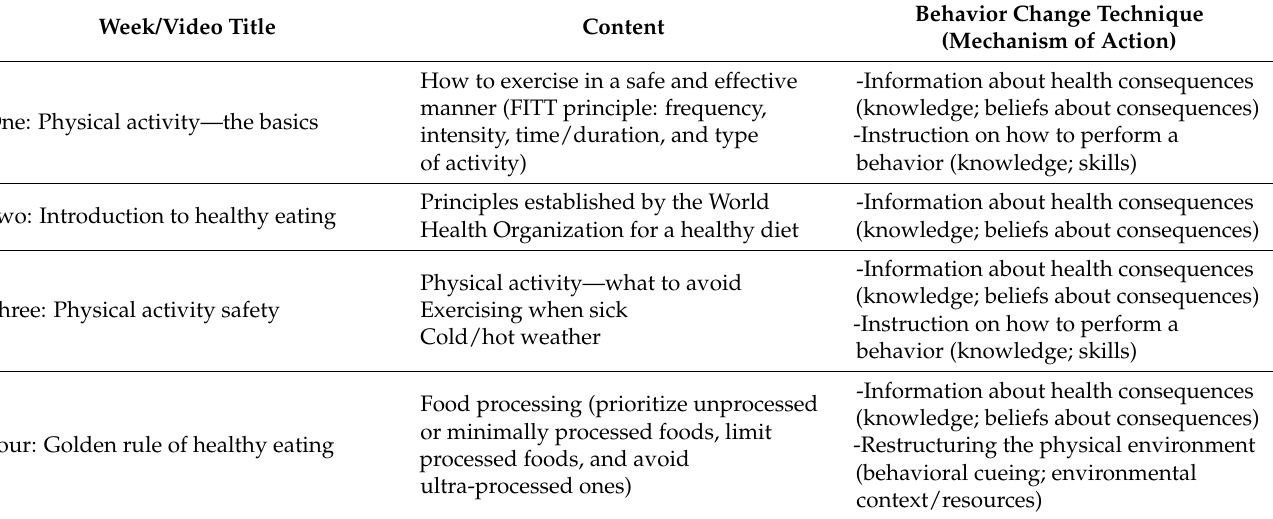
Table 1. Topic, content, behavior change techniques, and respective mechanisms of action of educa- tional